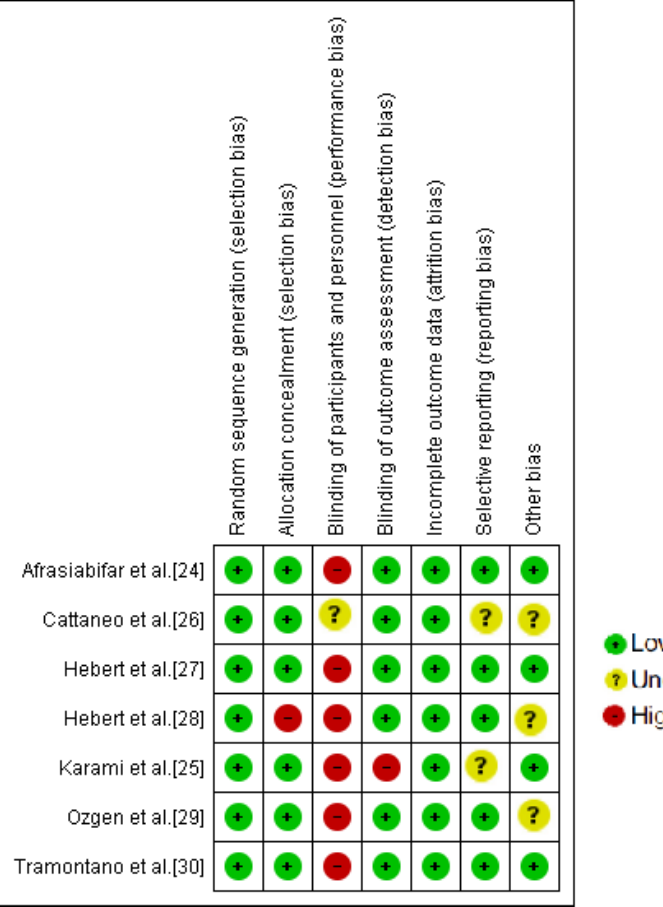
Figure 2. Cochrane risk of bias tool summary.